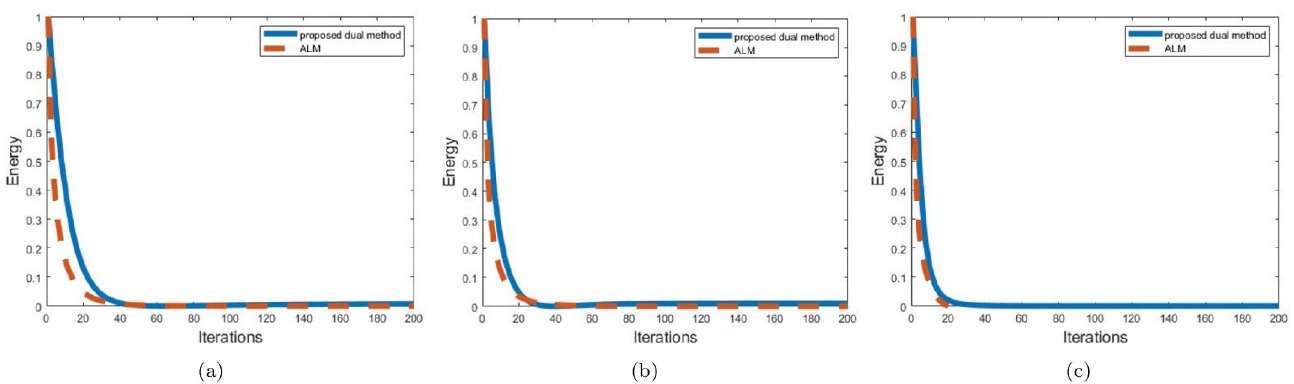
Fig 7. The first plot (a) shows the plots of objective function values versus iterations for the example ‘Ball’; plot (b) shows the example of ‘Baboon’; plot (c) shows the example of ‘Castle’.